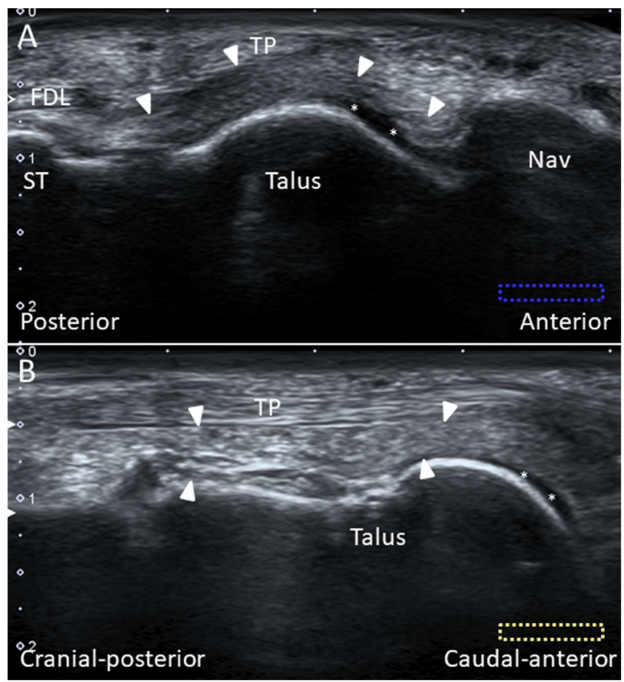
Figure 11. Imaging of the superomedial component of the spring ligament (arrowheads) ( A ). The spring ligament is in the oblique-short axis underneath the long axis of the tibialis posterior tendon ( B ). Please note the cartilage (asterisks) on the distal talus. The colored dashed rectangles are in accordance with the transducer positions in Figure 3A. FDL: flexor digitorum longus tendon; Nav: navicular; ST: sustentaculum